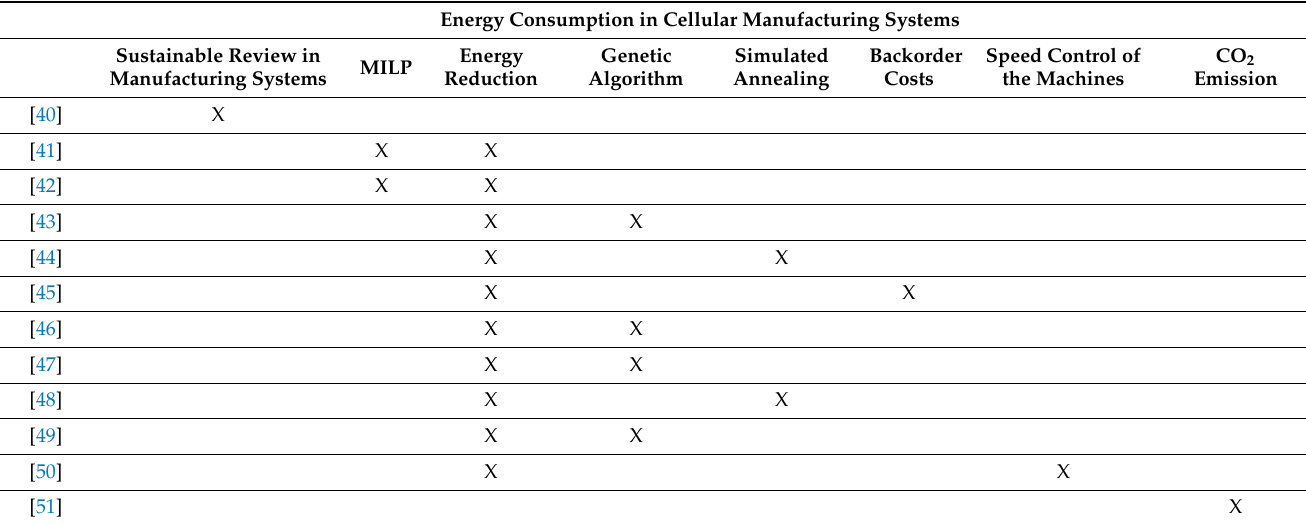
Table 2. Comparison among energy consumption